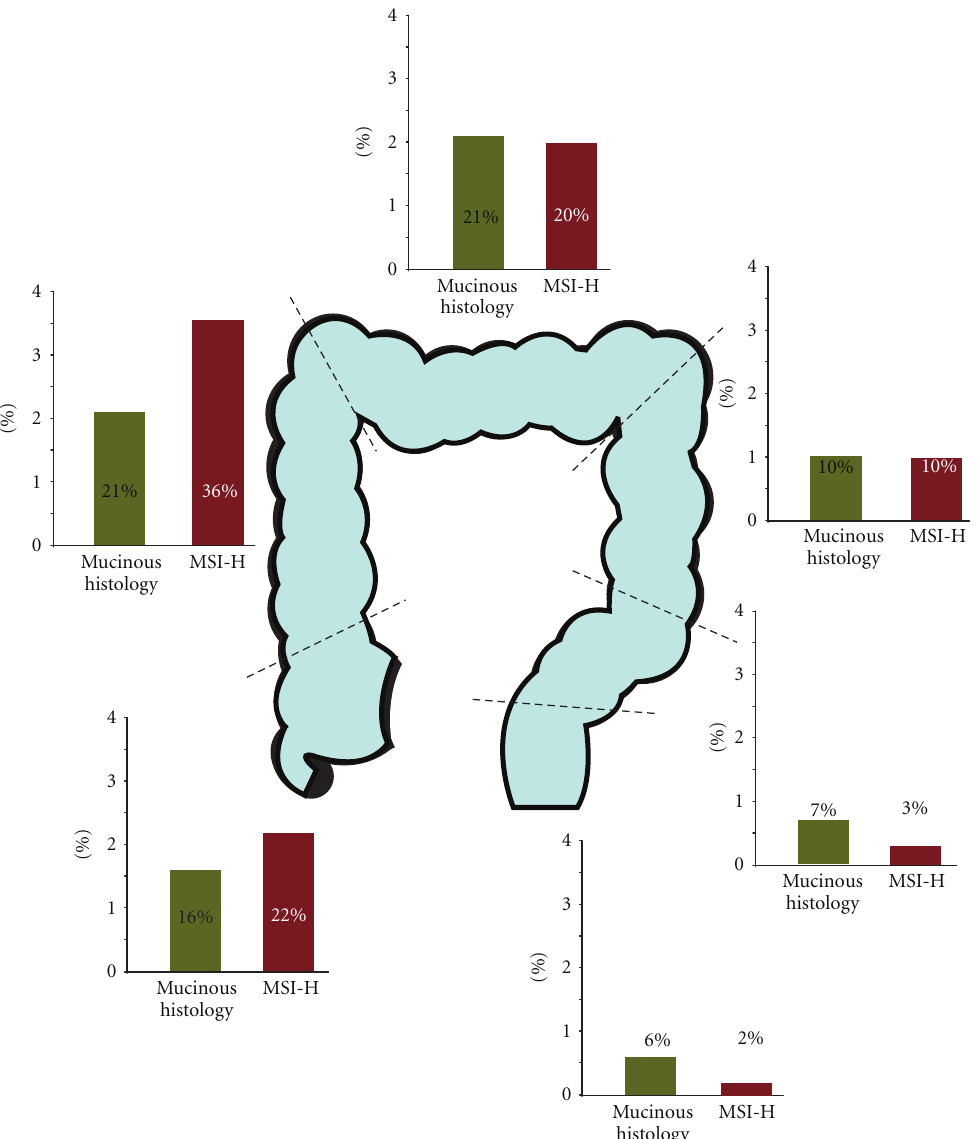
Figure 2: Incidence of mucinous histology and micosatellite instability by primary tumour site (data from Yamauchi et al.